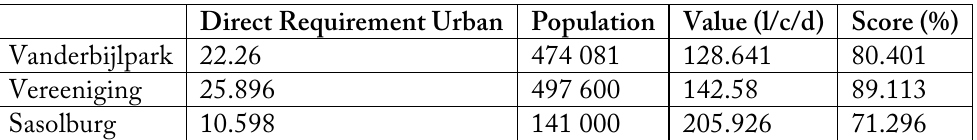
Table 5 Use component calculation